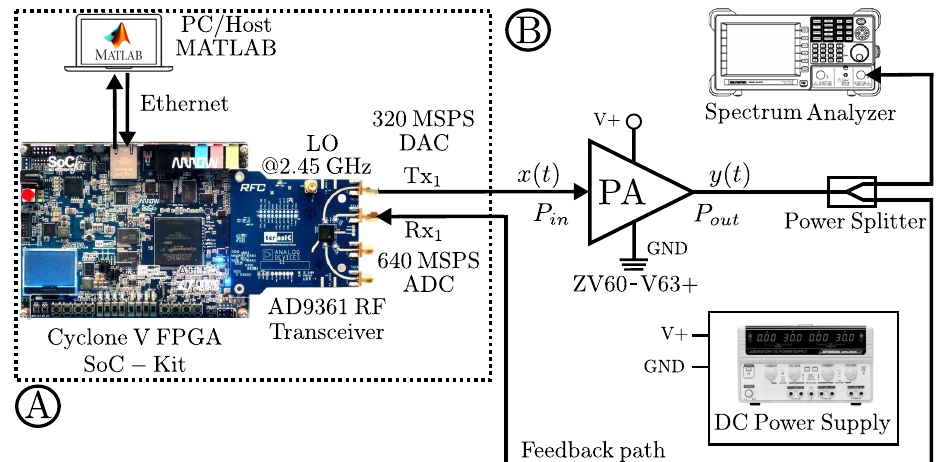
Figure 8. Proposed testbed block diagram of the characterization and linearization for the PA. ( A ) de- notes the FPGA digital to RF stage, and ( B ) analog part with devices and measurement